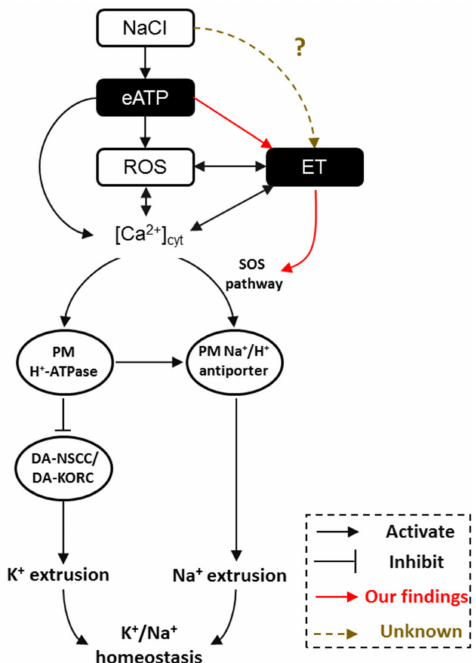
Figure 8. The proposed model of a multiple salt-signaling network involving eATP, ethylene, H 2 O 2 , and [Ca 2 + ] cyt in mediating K + / Na + homeostasis in Arabidopsis . When sodium ions (Na + ) are sensed by Arabidopsis roots, extracellular ATP is produced [10,30], resulting in ROS [8,30] and [Ca 2 + ] cyt [8,10] accumulation. Meanwhile, eATP activates ethylene signaling via upregulation of the expression of AtEIN3 , AtEIL1 , and AtETR1 (a novel finding in the present study). After that, interactions between ROS and [Ca 2 + ] cyt [8,29,30,32,33,46,56], ROS and ethylene [25,41,55], and ethylene and [Ca 2 + ] cyt [38–40,56] regulate the PM Na + / H + antiport system, including Na + / H + antiporter (via SOS pathway) and H + -ATPase (H + pumps). Furthermore, ethylene directly activates the SOS signaling pathway by increasing the transcription of AtSOS1 / 2 / 3 (a novel finding in the present study). Consequently, the PM Na + / H + antiporter helps to exclude the excess Na + and H + -ATPase inhibits DA-KORCs / DA-NSCCs to limit cytosolic K + leakage, namely by maintaining K + / Na + homeostasis in salinity stress. ET: ethylene; PM: plasma membrane; DA-KORCs: depolarization-activated K + outward rectifying channels; DA-NSCCs: depolarization-activated non-selective cation channels; ROS: reactive oxygen